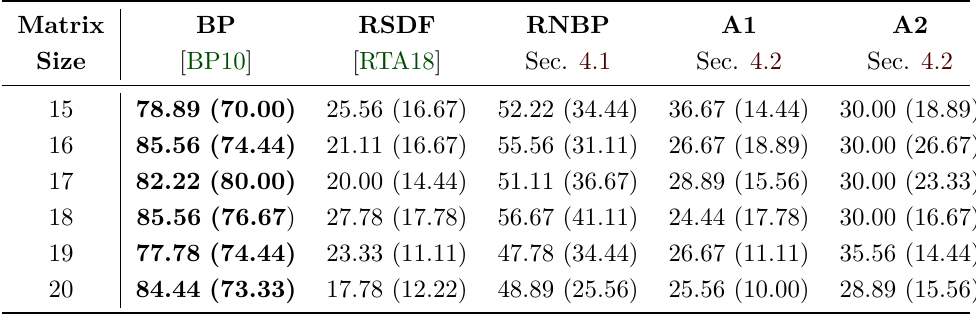
Table 5: Percentage of best ALOY circuits (Depth) produced by various algorithms for various square matrix sizes. The brackets contain the percentage of the BLOY circuits. The best percentages for both ALOY and BLOY circuits are highlighted in bold